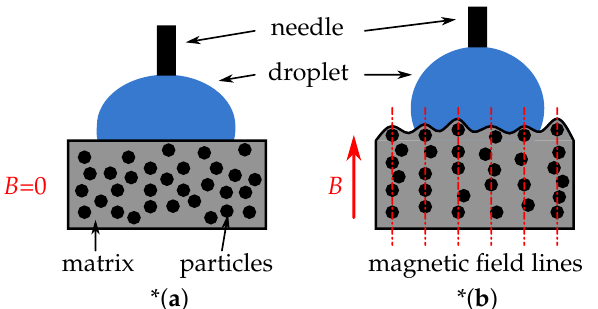
Figure 1. Schematic drawings of magnetic field-induced modifications of surface morphology of MAEs. The red arrow indicates the field direction. ( a ) Initial (“smooth”) MAE surface. ( b ) Increased surface roughness due to magnetic-field-induced restructuring of the filler due to the rearrangement of filler particles. *Note that magnetic particles are attached to the matrix. Therefore, the compliant polymer matrix becomes deformed in the magnetic field [58]. These internal deformations of the matrix are not depicted in the